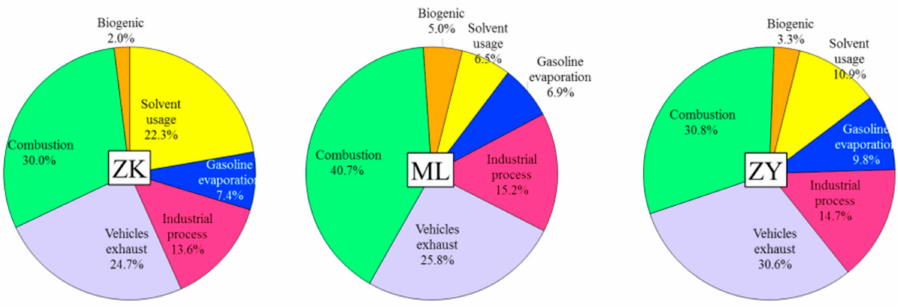
Figure 8. The spatial distributions of the relative contributions (%) in VOCs